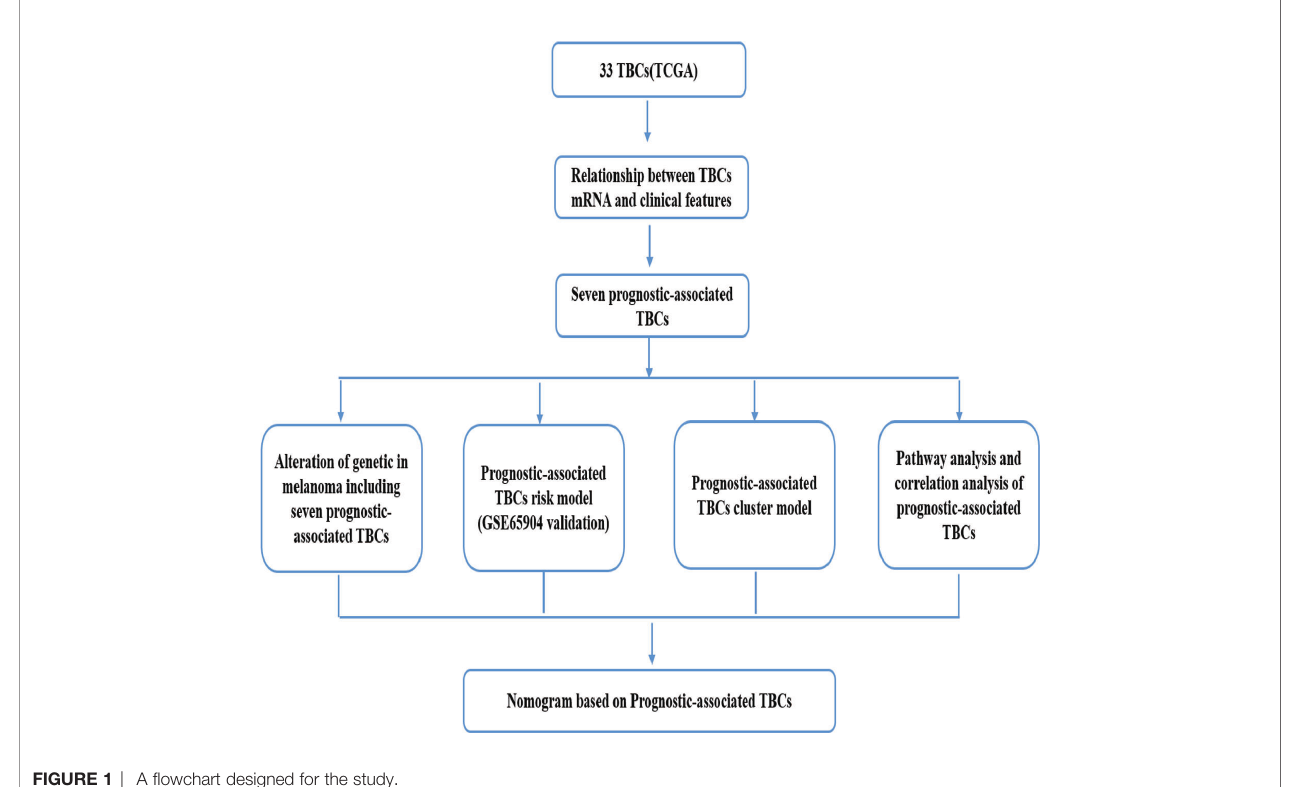
FIGURE 1 | A fl owchart designed for the study.